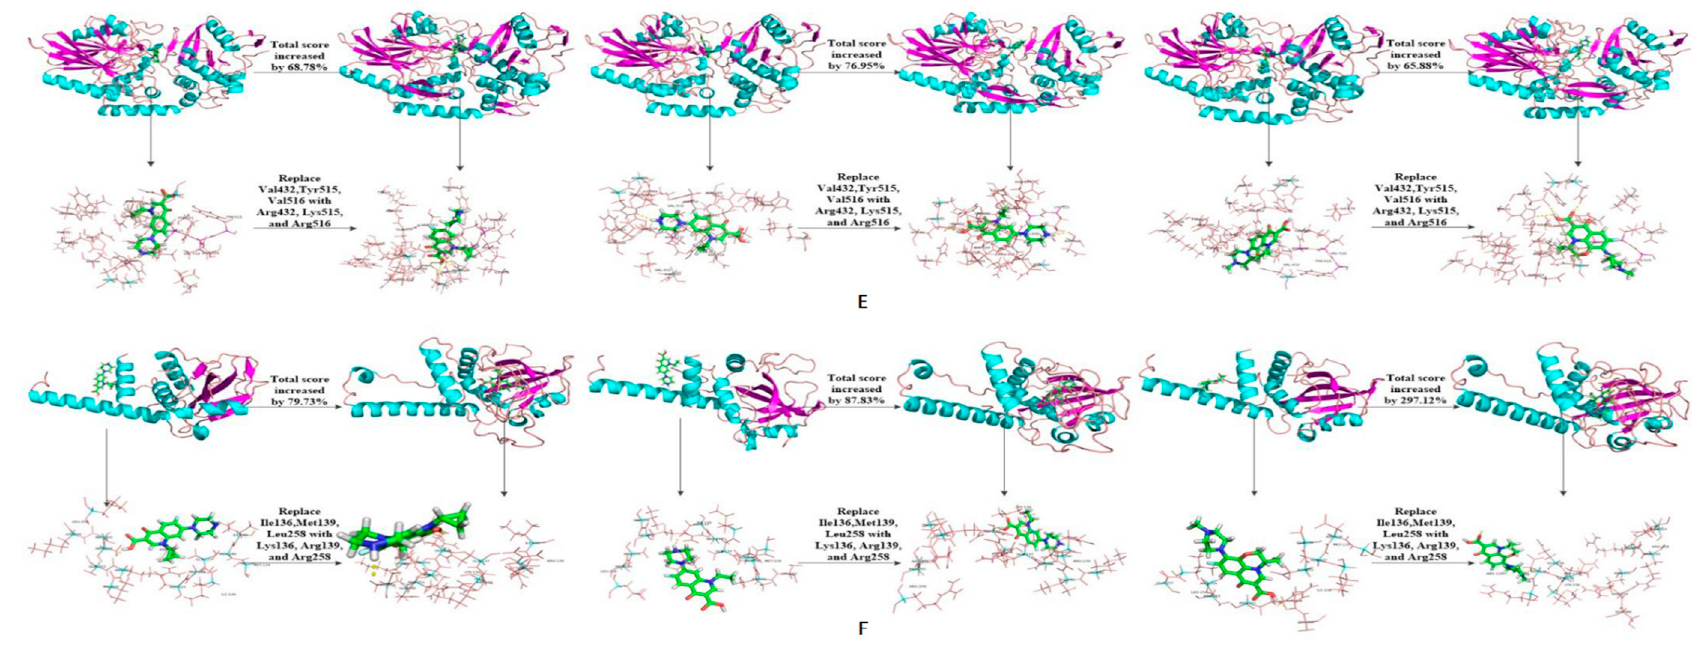
Figure 4. Schematic diagram of the structure of the target fluoroquinolone molecule before and after the degrading enzymes modification. ( A – F ) respectively represent the schematic diagram of the binding of the degrading enzymes with PDB ID of 1YZP, 4DTE, 3NQA, 1E1D, 1USH 2DYT and CIP, OFL, NOR).